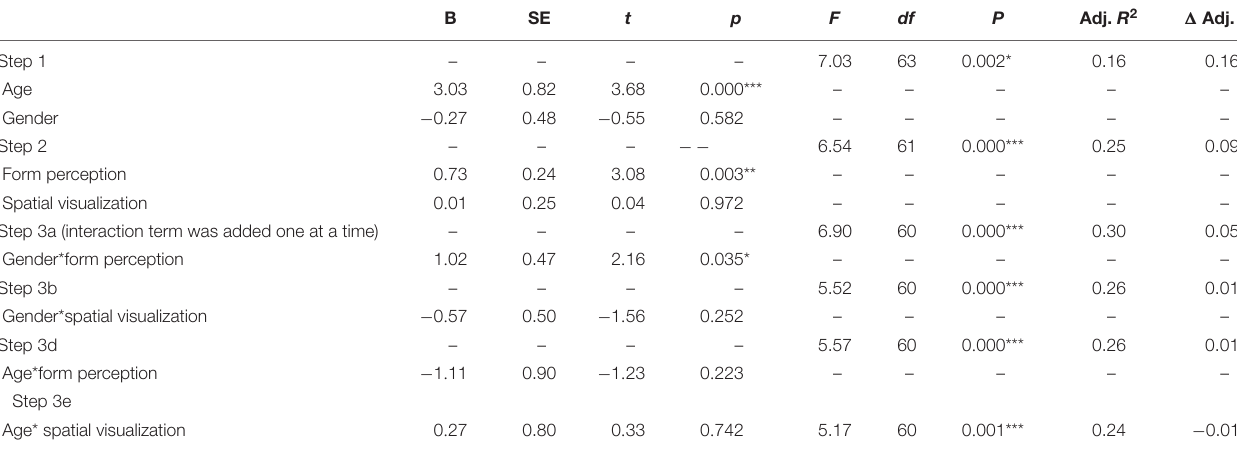
TABLE 2 | Hierarchical linear regression of form perception and spatial visualization predicting block building ability ( N = 66).